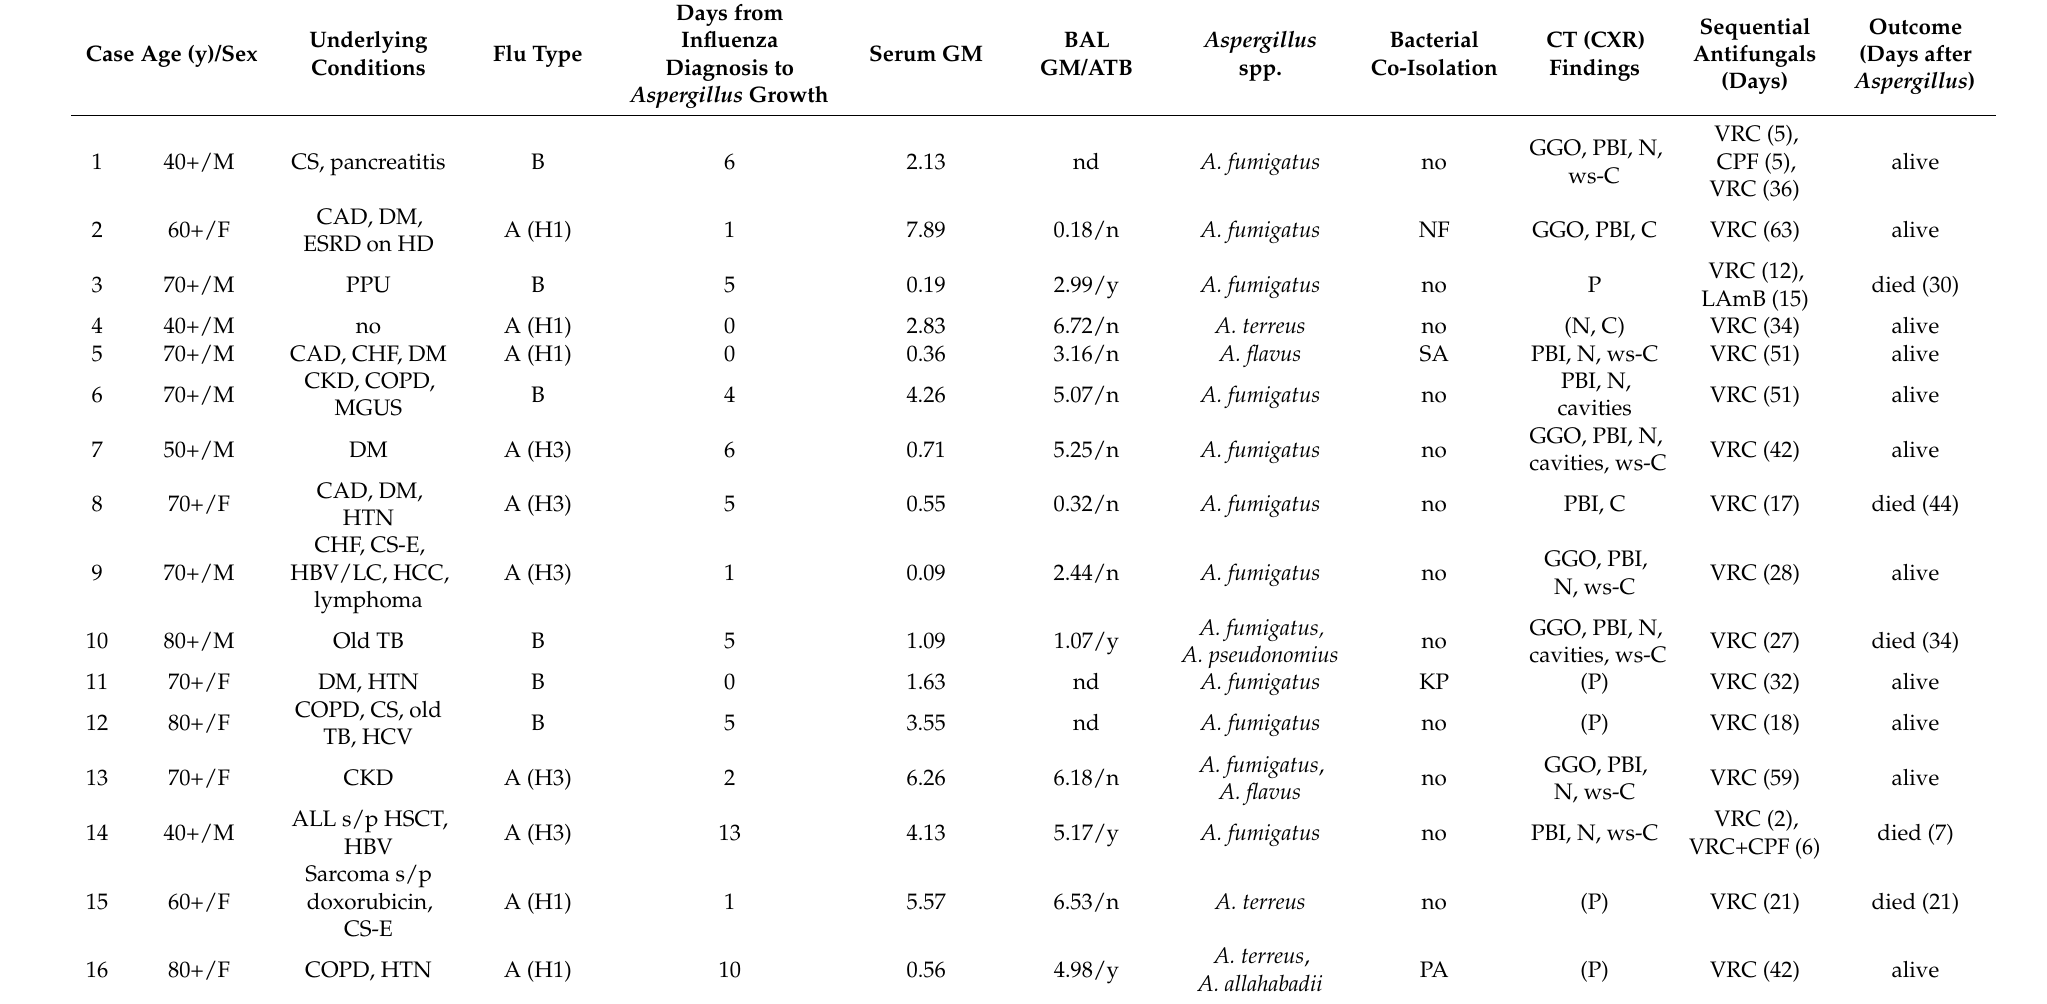
Table 2. Clinical and laboratory data of 24 patients with proven or probable influenza-associated pulmonary aspergillosis based on the Amsterdam IAPA